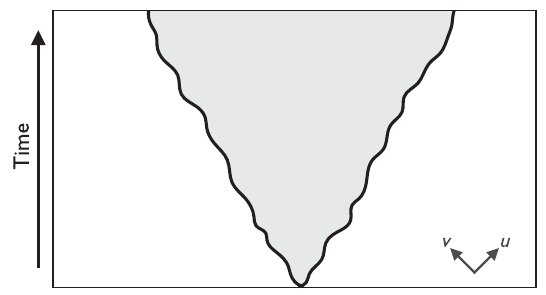
FIG. 12. The calculation of the OTOC in the spacetime picture leads to a partition function for two nonintersecting directed random walks (domain walls in an effective Ising model). These walks have a bulk energy cost [Eq. (69)] and a boundary potential [Eq. (70)] that biases them to a positive and negative velocity, respectively. Directions of null coordinates u , v used in the text are